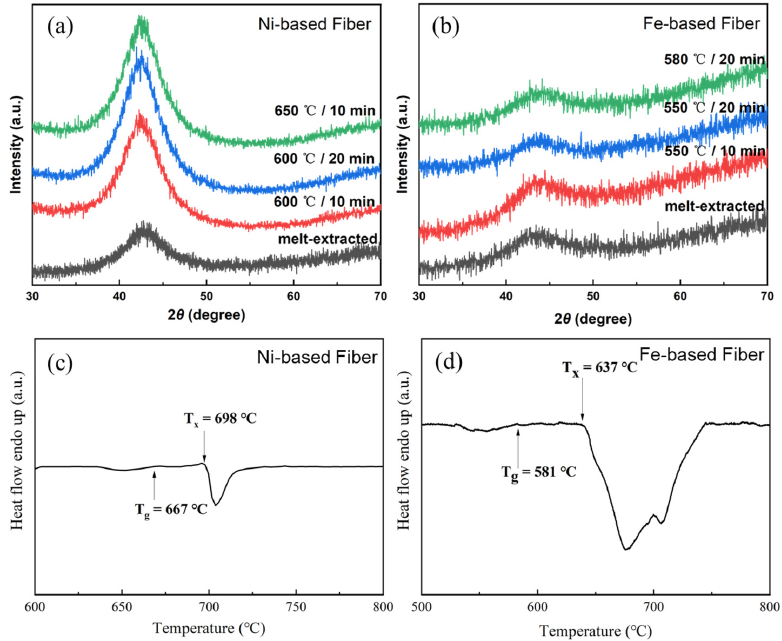
Figure 2. XRD and DSC patterns of melt-extracted AMFs, ( a ) XRD of Ni-based fibers, ( b ) XRD of Fe- based fibers, ( c ) DSC of Ni-based fibers, and ( d ) DSC of Fe-based fibers. Fe-based fibers, ( c ) DSC of Ni-based fibers, and ( d ) DSC of Fe-based